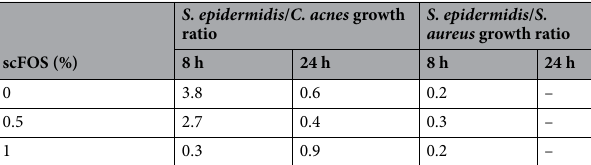
Table 4. Competition of bacterial strains for scFOS on human reconstructed epithelium (RHE). Spread plate colony count of S. epidermidis and C. acnes competition for scFOS as well as S. epidermidis and S. aureus competition for scFOS at different concentrations on RHE, expressed as fold-change compared to the bacterial load at t = 0. Results are expressed as mean ± SD of three independent experiments. – value non calculated due to one 0